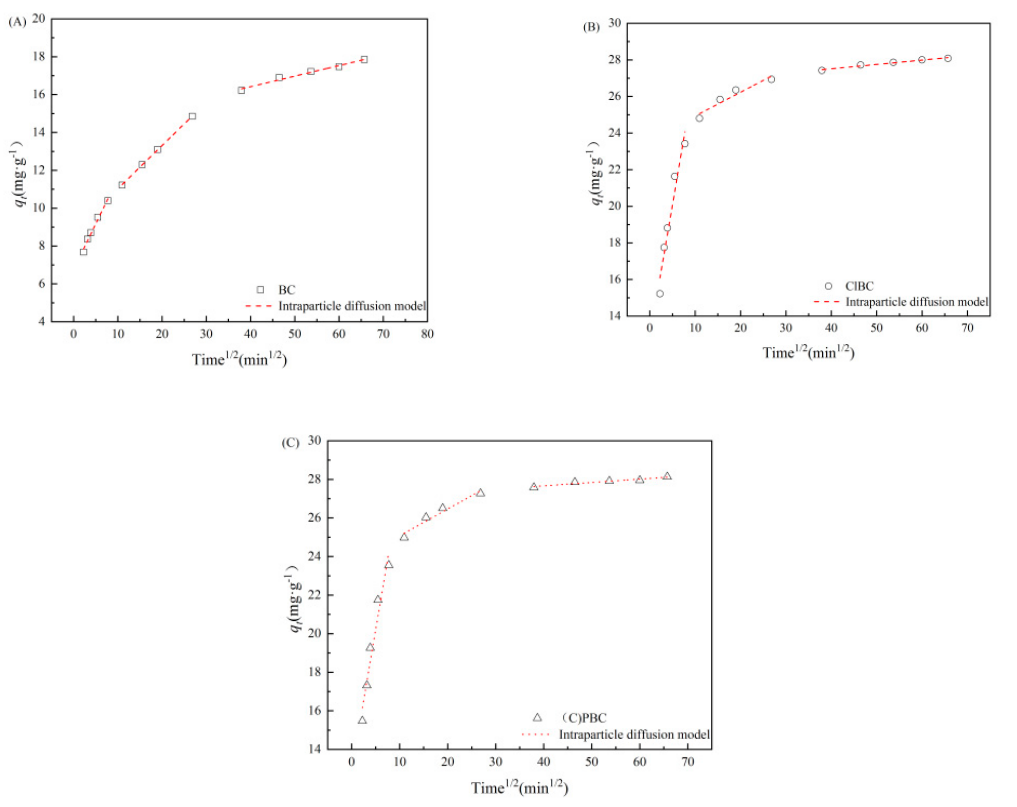
Figure 4. IPD model for SMX adsorption on ( A ) BC, ( B ) ClBC and ( C ) PBC.